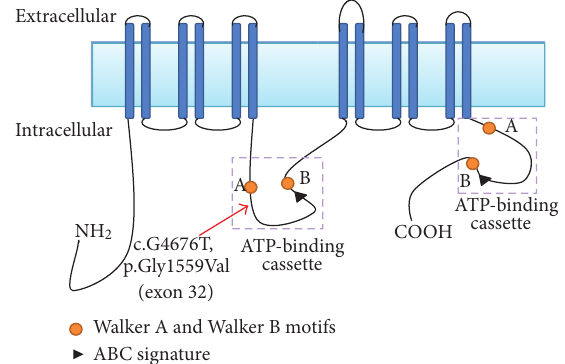
F 4: Schematic representation of the ABCA12 protein and predicted location of mutation. e mutation will exert its effect on the Walker A motif of the 1st ATP-binding cassette; an area within the nucleotide-binding domain.